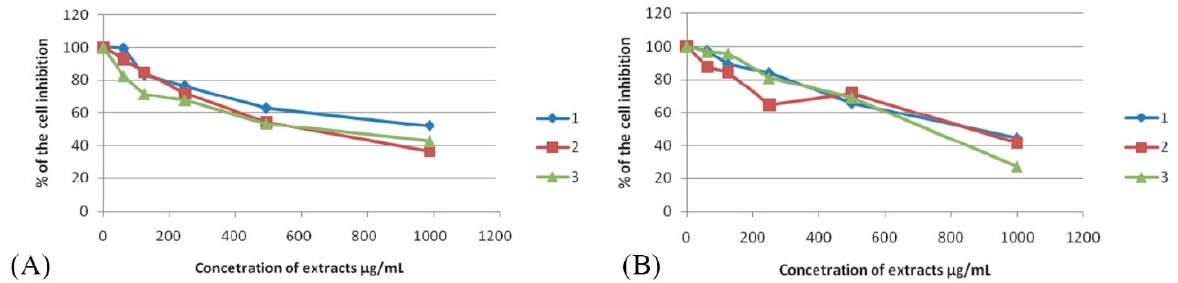
Figure 2. Representative graph of HeLa ( A ) and FemX ( B ) cells survival after 72 h cell growth in the presence of increasing concentrations of studied extracts P. spinosa (1), M. germanica (2), and C. monogyna (3).